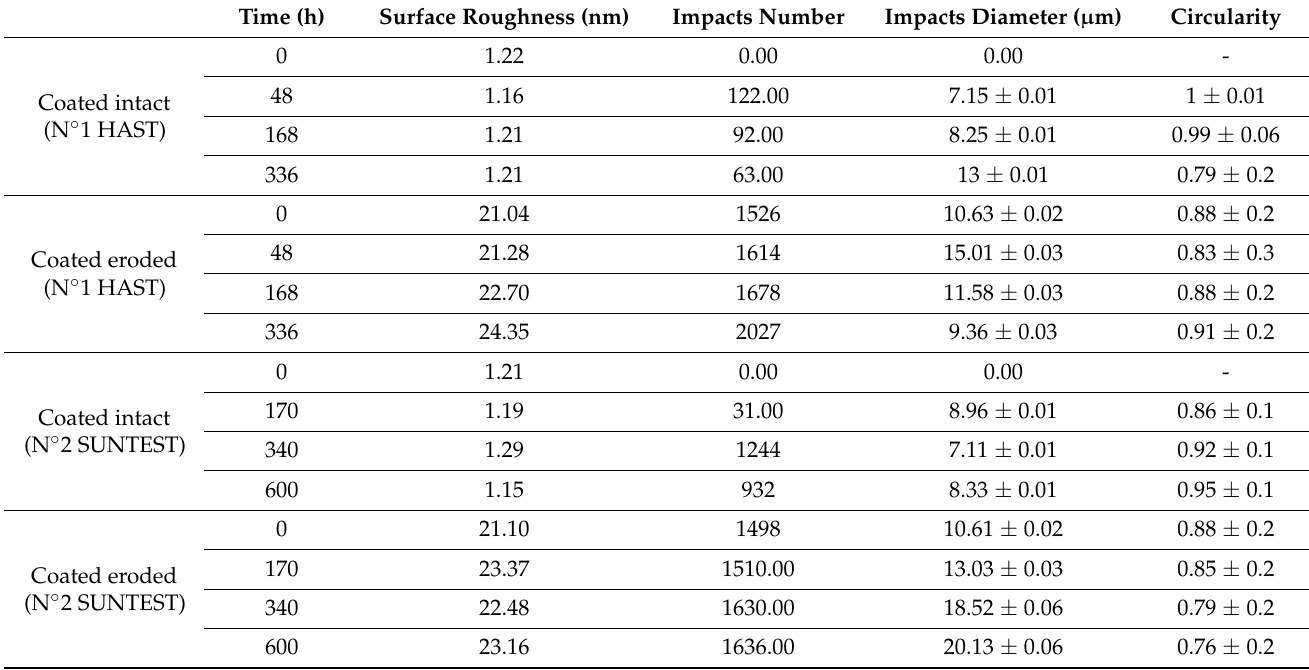
Table 4. Impacts properties and surface roughness of coated